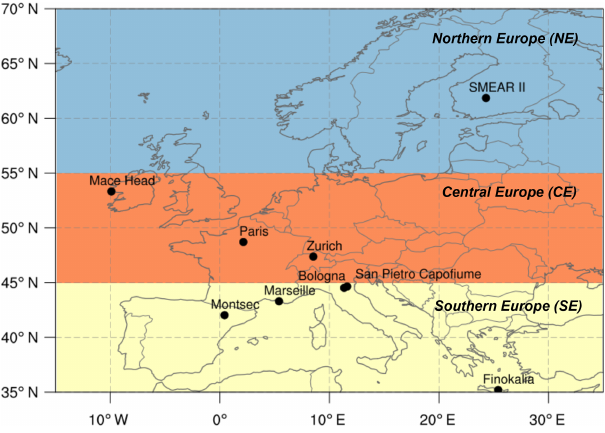
Figure 1. Model domain and location of ACSM/AMS measurement